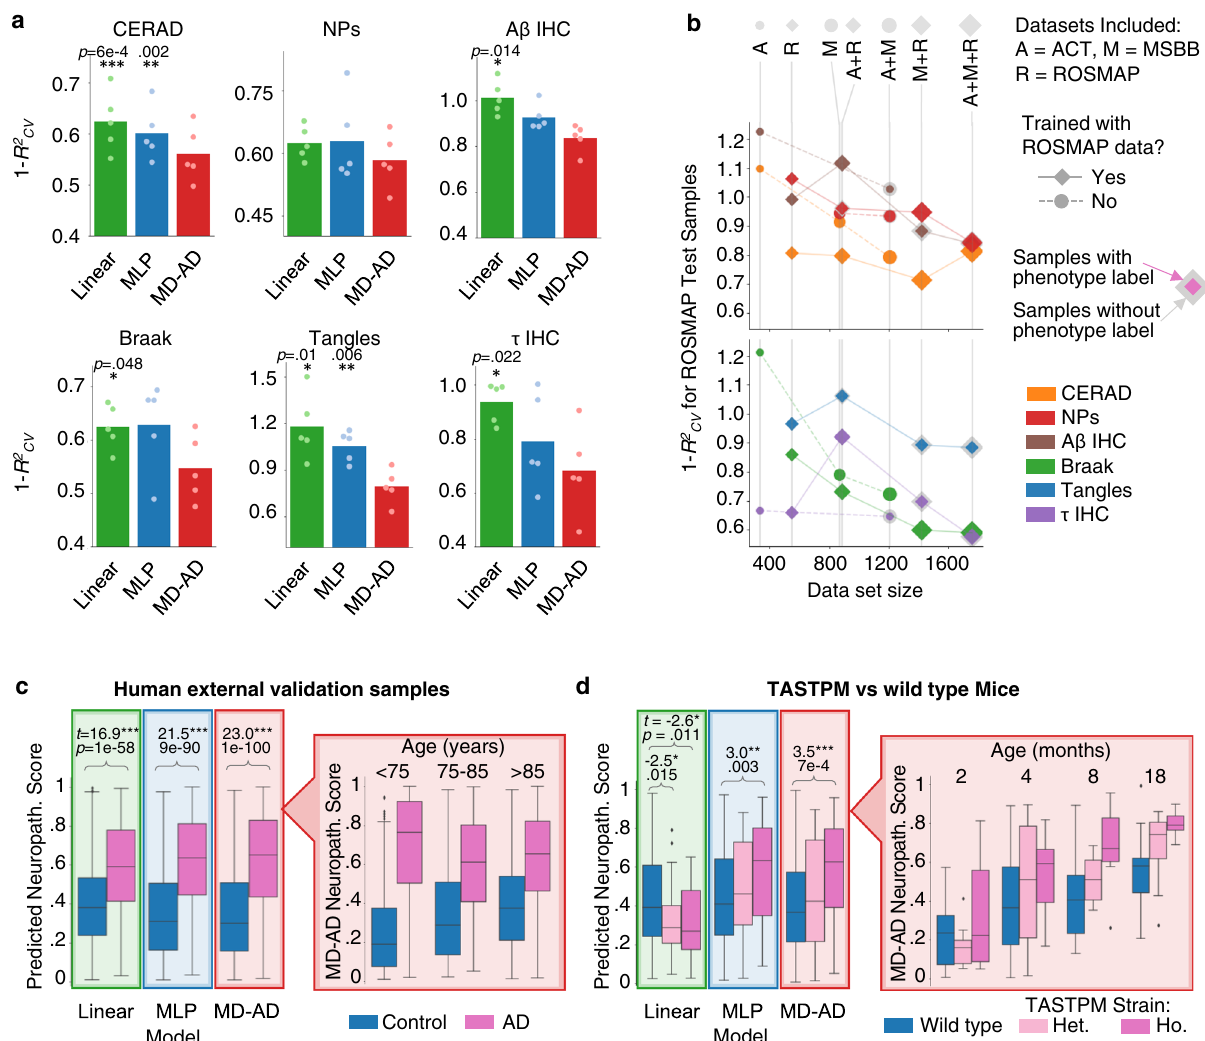
Fig. 2 MD-AD prediction performance for within-sample test data and out-of-sample (external validation) data. a Average test set 1- R 2 CV (prediction error metric calculated by dividing the mean squared error by the label ’ s variance) for phenotype predictions across fi ve test splits (values from each run as dots). MLP: multiple layer perceptron. Linear: linear model using L2 regularization (two-sided paired t test comparing alternative methods with MD-AD, p values: *<0.05, **<0.01, ***<0.001; n = 5 runs of each method). b Average 1- R 2 CV for ROSMAP test set samples when training on subsets of the available datasets in the training set. c For samples from three external validation datasets, we obtain neuropathology scores for each sample from each model. Left: box plots displaying the distribution of predicted neuropathology scores from each method. T test highlight between-group differences for each method (two-sided independent t test, *** p < 0.001). Right: box plots displaying the distribution of MD-AD ’ s predicted neuropathology scores split by age group and diagnosis (see Supplementary Figure 4b for sample sizes broken down by age and diagnosis and signi fi cance of pair-wise differences). Test statistics were calculated based on 565 AD cases and 482 controls. All box plots in this fi gure indicate median (center line), upper and lower quartiles (box limits), 1.5 × interquartile range from quartiles (whiskers), and outliers (points). d Left: box plots displaying the distribution of predicted neuropathology scores from each method for wild type and TASTPM (both heterozygous and homozygous) mice. T tests highlight between-group differences for each method (two-sided t test, p values: *<0.05, **<0.01, ***<0.001). Right: box plots displaying the distribution of MD-AD ’ s predicted neuropathology scores for mice split by age and strain (See Supplementary Figure 4c for sample sizes and signi fi cance of pair-wise differences). Test statistics were calculated based on